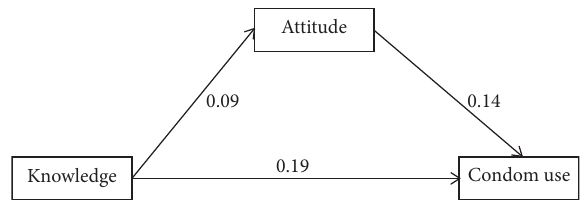
Figure 3: Path analysis showing association between knowledge and attitude towards condom use with its